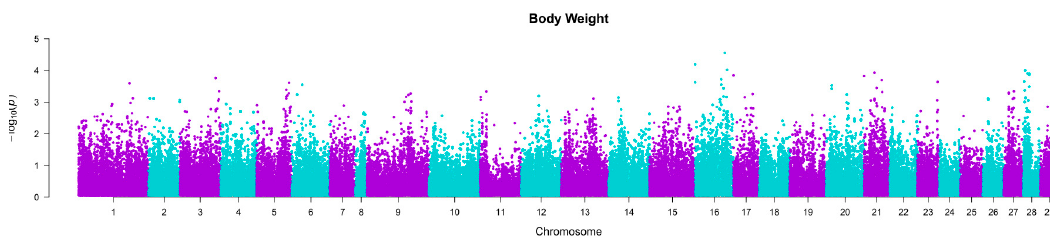
Figure 1. The Manhattan plot of body weight in the GWAS of Population 1 [14]. The Bonferroni genome-wide significance threshold is p ~4.50 × 10 -7 .